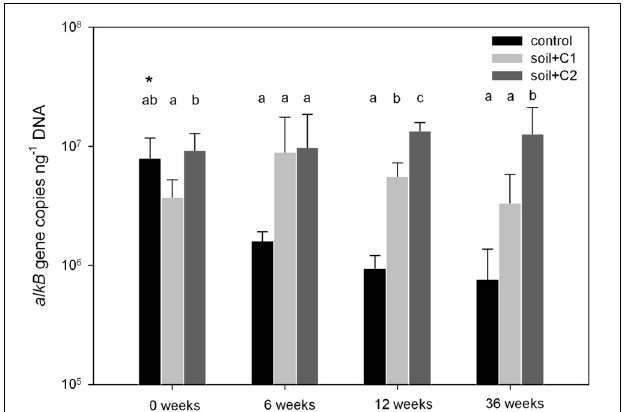
FIGURE 1 | Gene copy numbers of alkB related to ng DNA for different soil treatments. Significant different treatments within one sampling time point are indicated with different letters, the asterisk indicates significant differences over time within one treatment ( n = 5, p -value < 0.05 based on ANOVA analysis). Sampling after 6 weeks revealed no significant differences due to high standard deviations (indicated by error